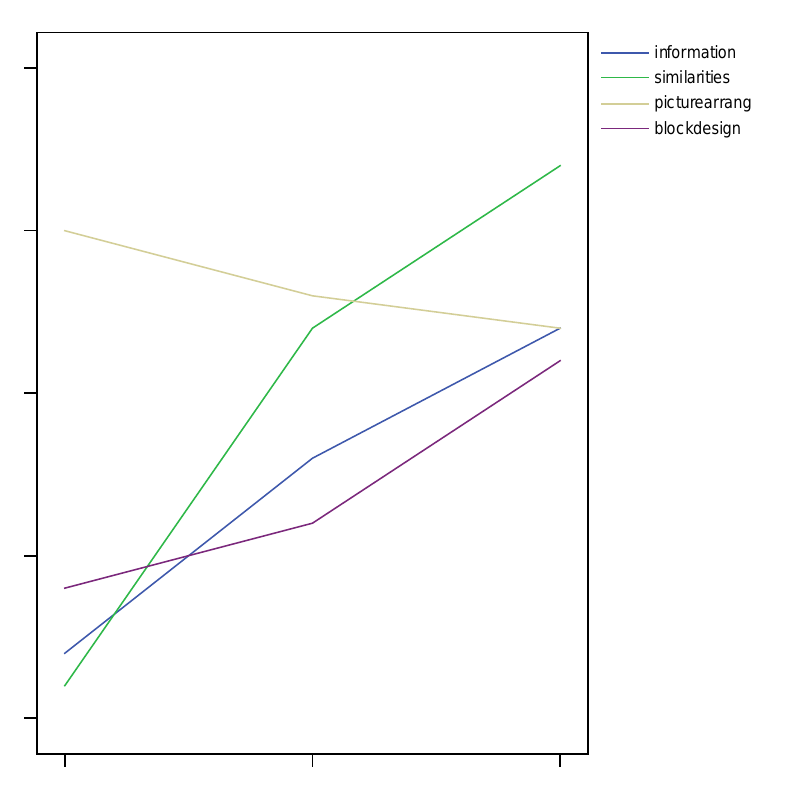
FIGURE 1. The magnitude of the correlation coefficients from early, intermediate, and late trials of the letter cancellation